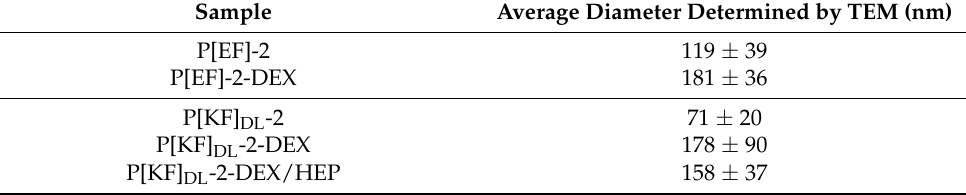
Table 5. Average diameters of nanoparticles and their DEX-conjugated forms are calculated from TEM